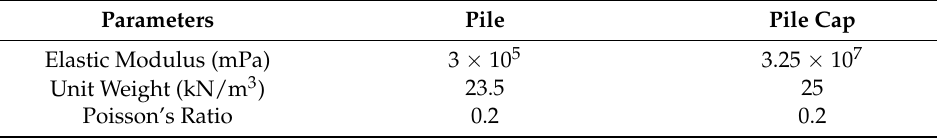
Table 4. Structural properties adopted in the numerical